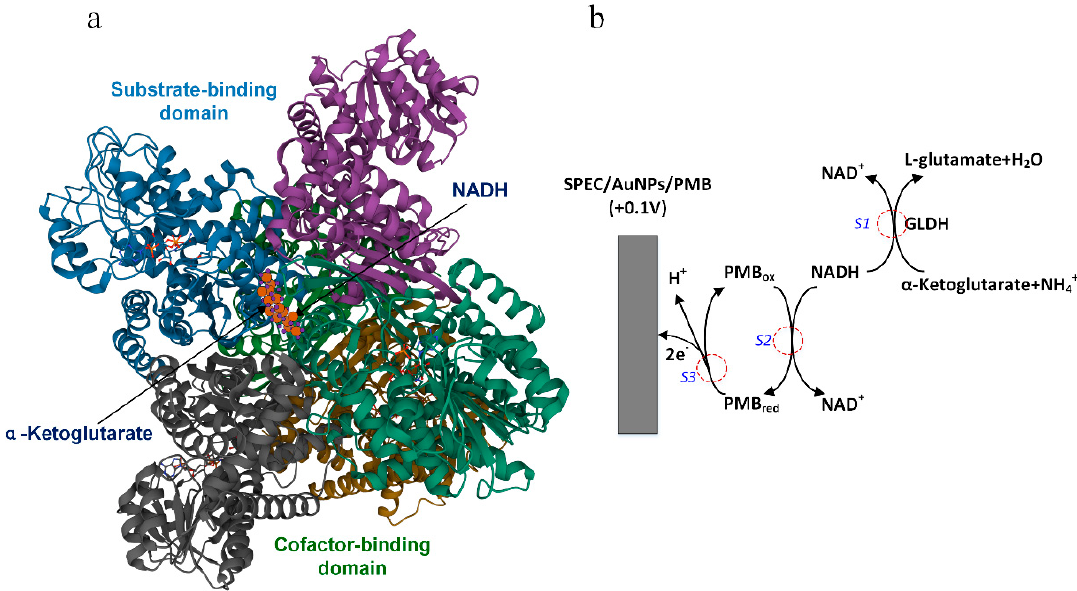
Figure 1. Schematic illustration of ammonia nitrogen detection. Crystal structure of glutamate dehydrogenase from Corynebacterium glutamicum ( a ). The various reactions taking place during operation of biosensor ( b ). S1—enzymatic reaction, S2—chemical reduction, S3—electrochemical re-oxidation.